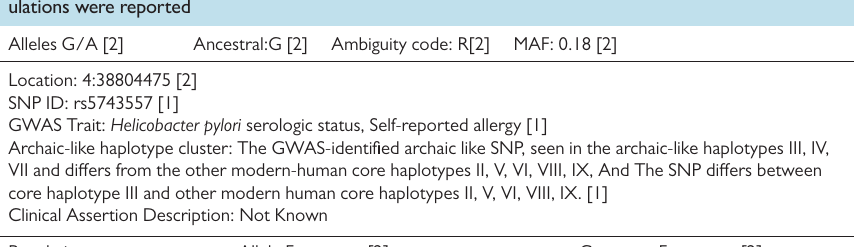
Table 1. Shows a detailed information for the SNP rs5743557. Detailed report was created for each SNP. MAF, chromosomal location, clinical significance, allele frequencies for each population including sub-pop- ulations were